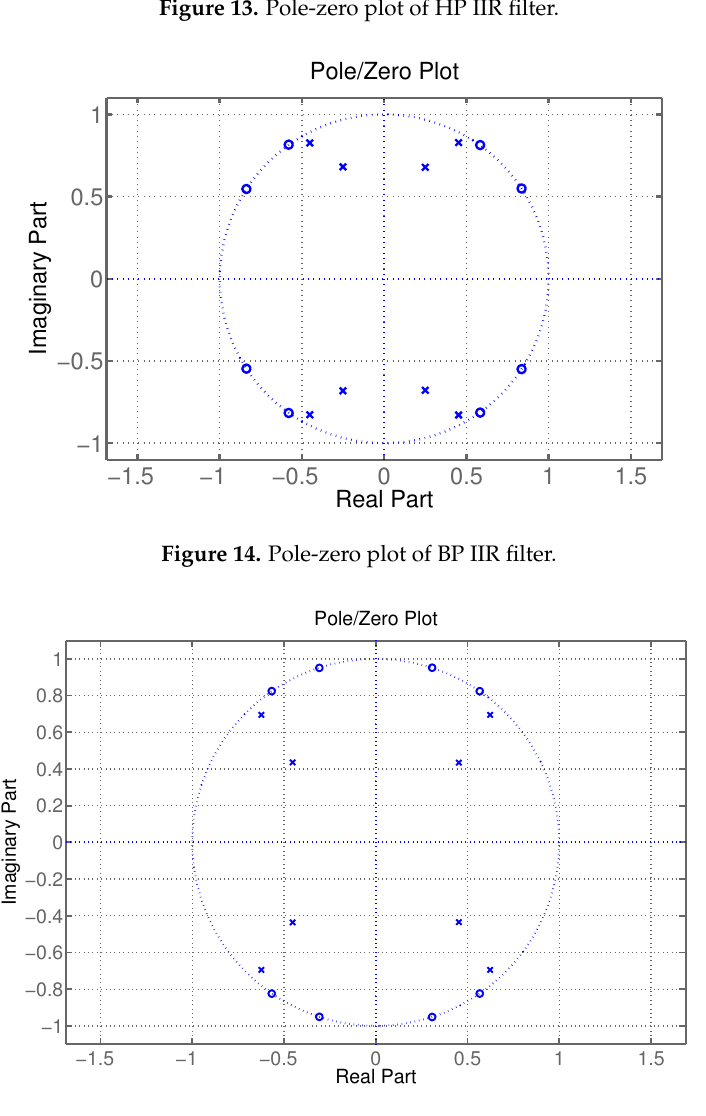
Figure 15. Pole-zero plot of SB IIR